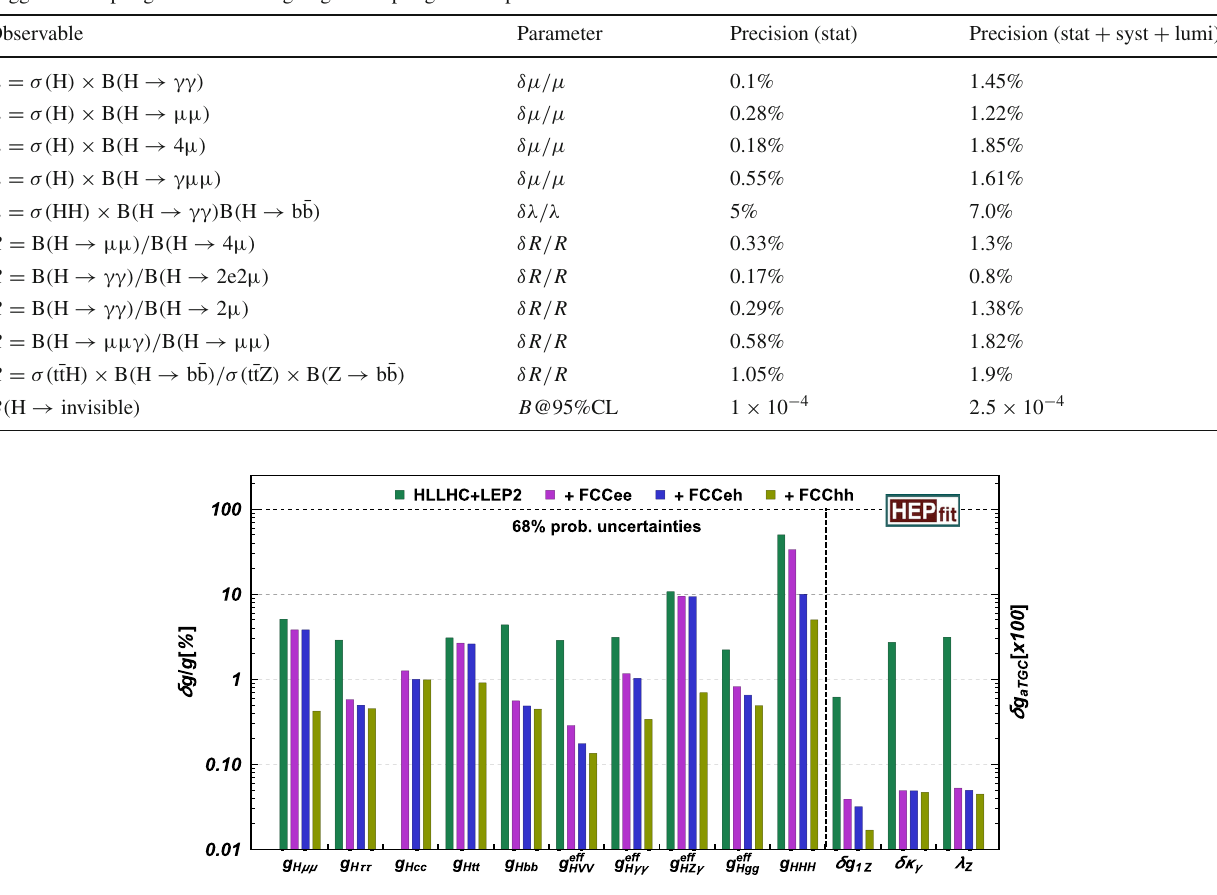
would be possible by combining each FCC stage with the previous knowledge at that time (precisions at each FCC stage considered indi- vidually, reported in Tables S.1 and S.2 in the κ framework, are quite